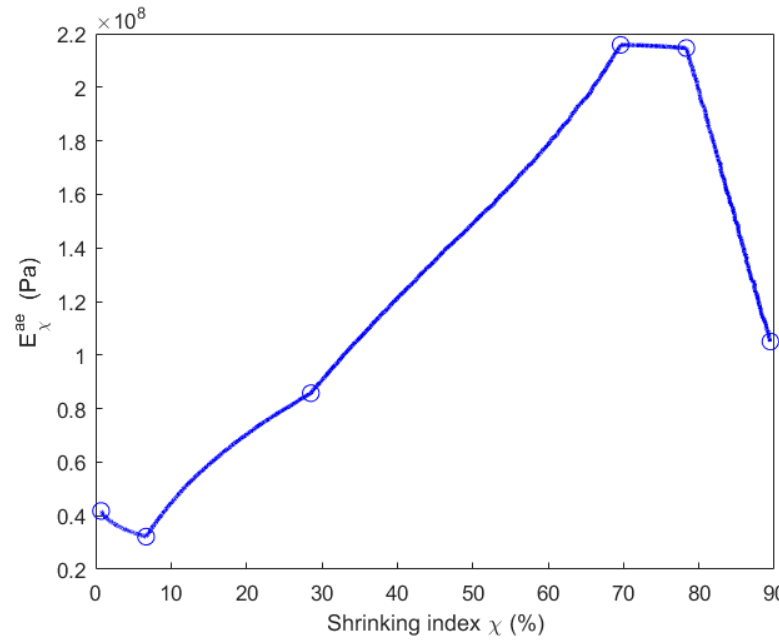
ae E χ with respect to the shrinking index.